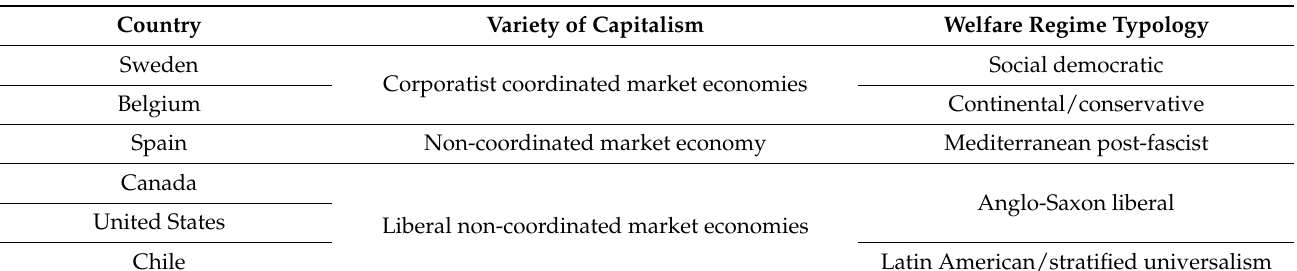
Table 1. Division of countries according to variety of capitalism or model of economic organization and welfare regime